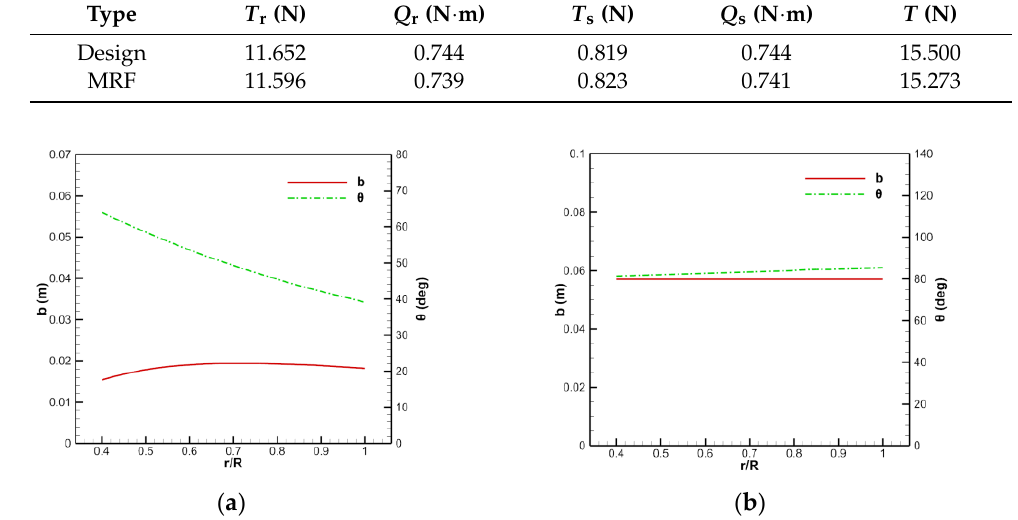
state: ( a ) Rotor, ( b ) stator.